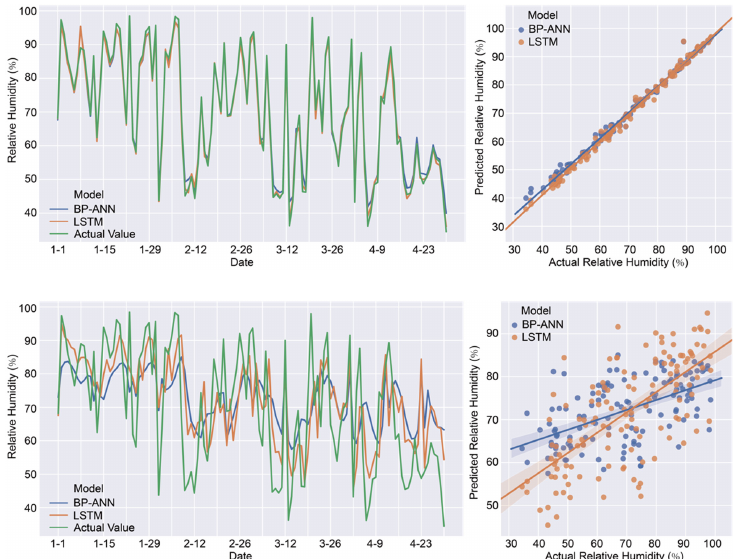
Figure 10. The prediction results of daily average RH using BP-ANN and LSTM techniques in Model 1 ( up ) and 2 ( below ).